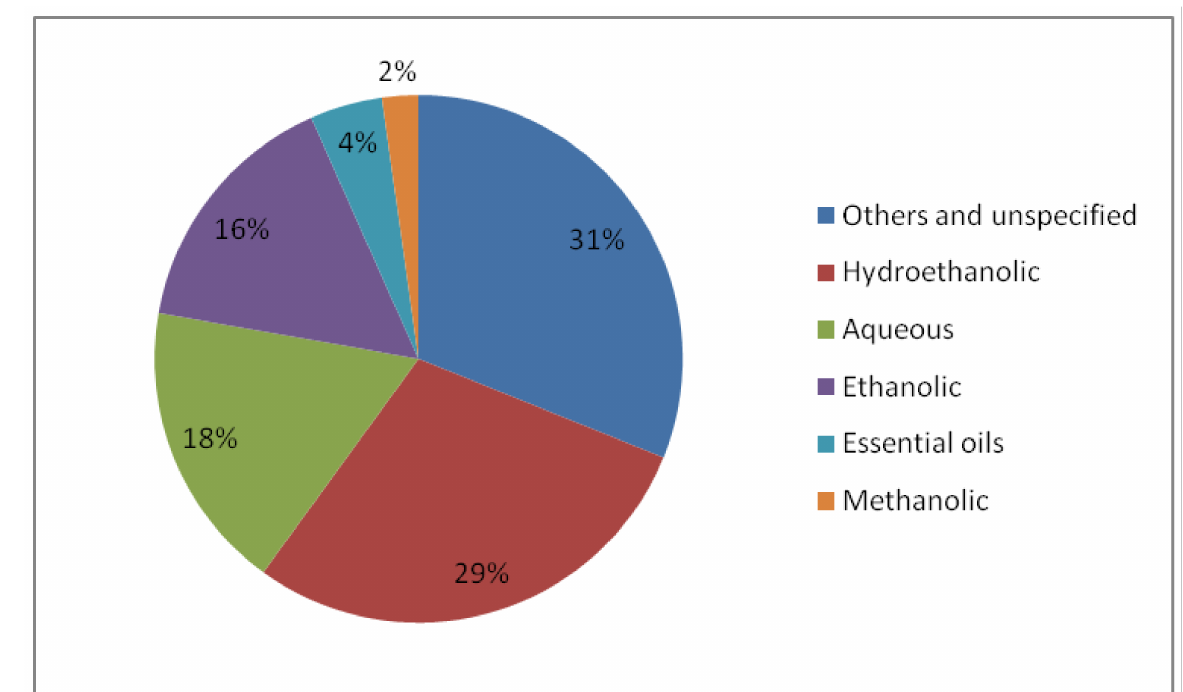
Figure 3. The types of propolis extract used in the included studies. Table 3 illustrates the geographic locations of the propolis sources and bioactive compounds where whole propolis was not used in the studies; Egypt (6%), Algeria (1%), (3%), Indonesia (1%), Malaysia (1%), Brazil (10%), unspecified (19%), and other bioactive compounds (30%). The percentages are rounded to the nearest whole number. Table 3. The percentages of studies that utilize propolis bioactive compounds and/or the geographi- cal locations of the propolis source in the included